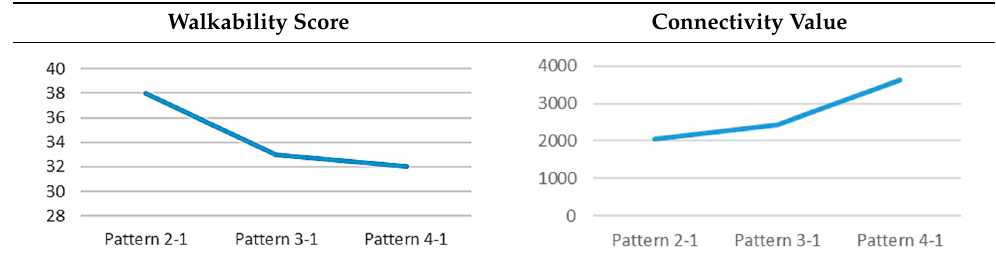
Table 7. Comparative analysis for the walkability and connectivity value.